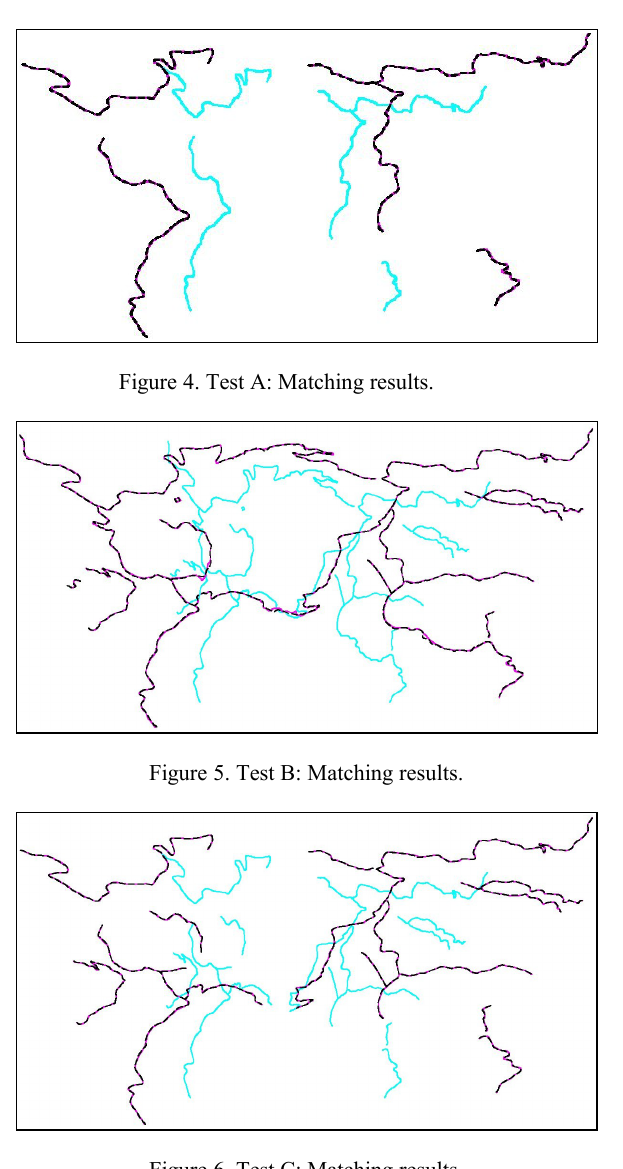
Figure 6. Test C: Matching results.